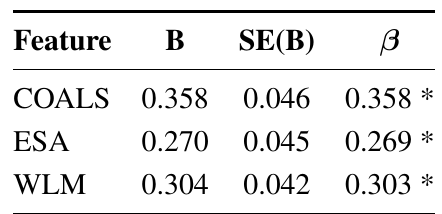
Table 6. Regression on ranks of COALS, ESA, and WLM, for human judgment ranks (N =